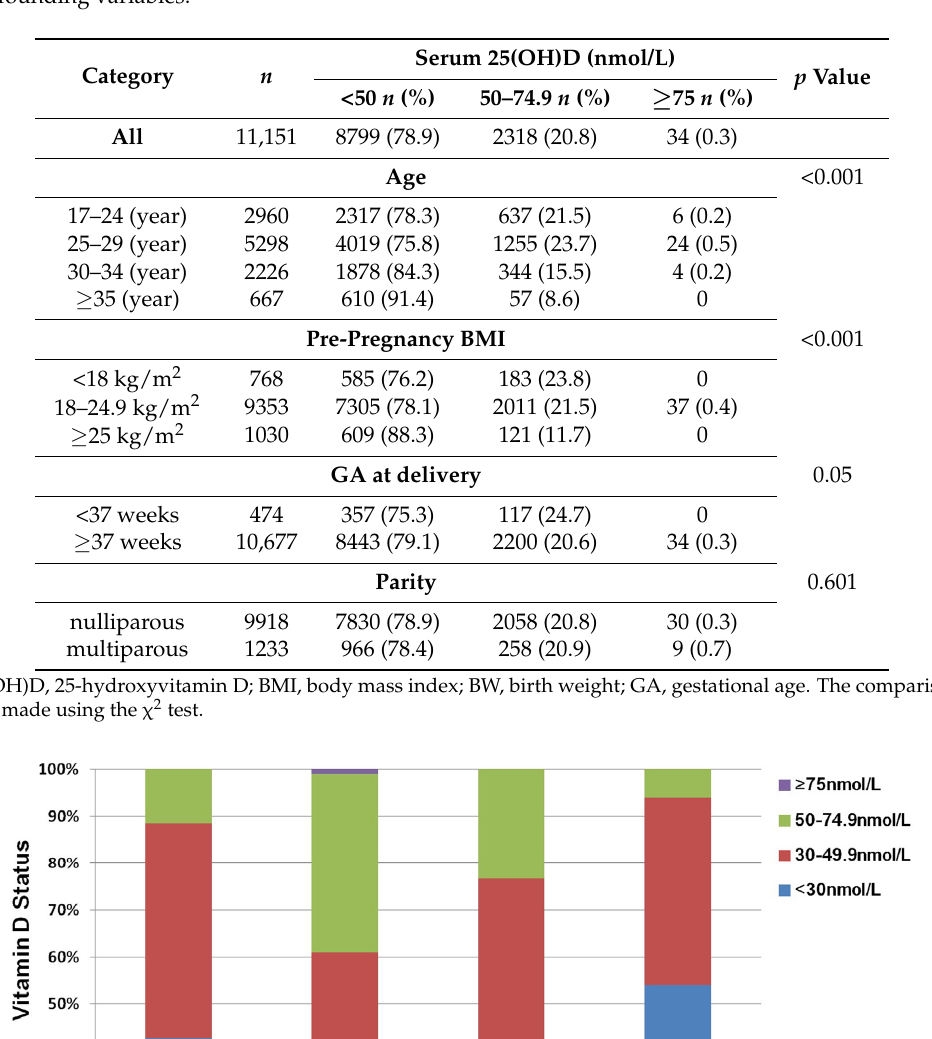
Table 2. The serum 25(OH)D concentration of pregnant women according to categories of relevant confounding variables.